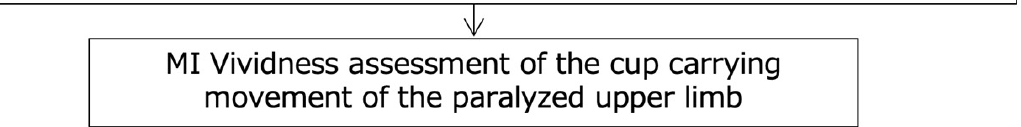
Figure 3. The experimental protocol. Participants were given three MI tasks: an MI task without an inverted image (MI only), an MI task with an inverted image of another person’s hand (other hand action observation [AO] + MI), and an MI task with an inverted image of their own hand (own hand AO + MI). The subjective MI vividness was assessed immediately after the MI tasks were completed using the recorded NIRS measurements.